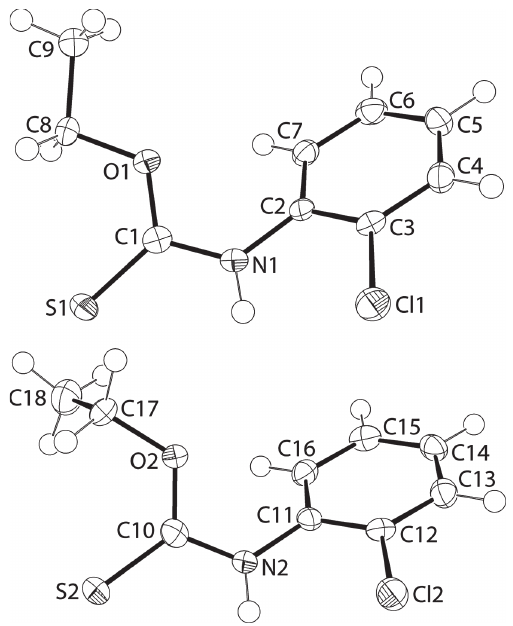
Table 1: Data collection and